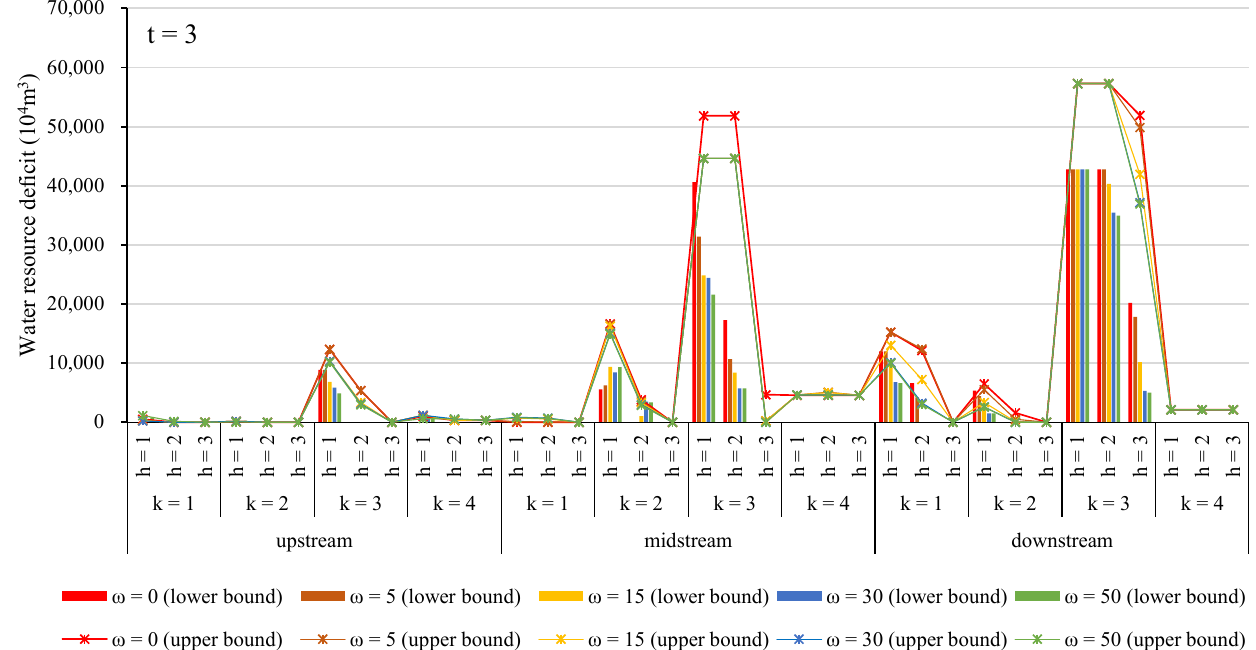
Figure 10. Water resource deficits by region in the Fenhe River Basin in period 3.